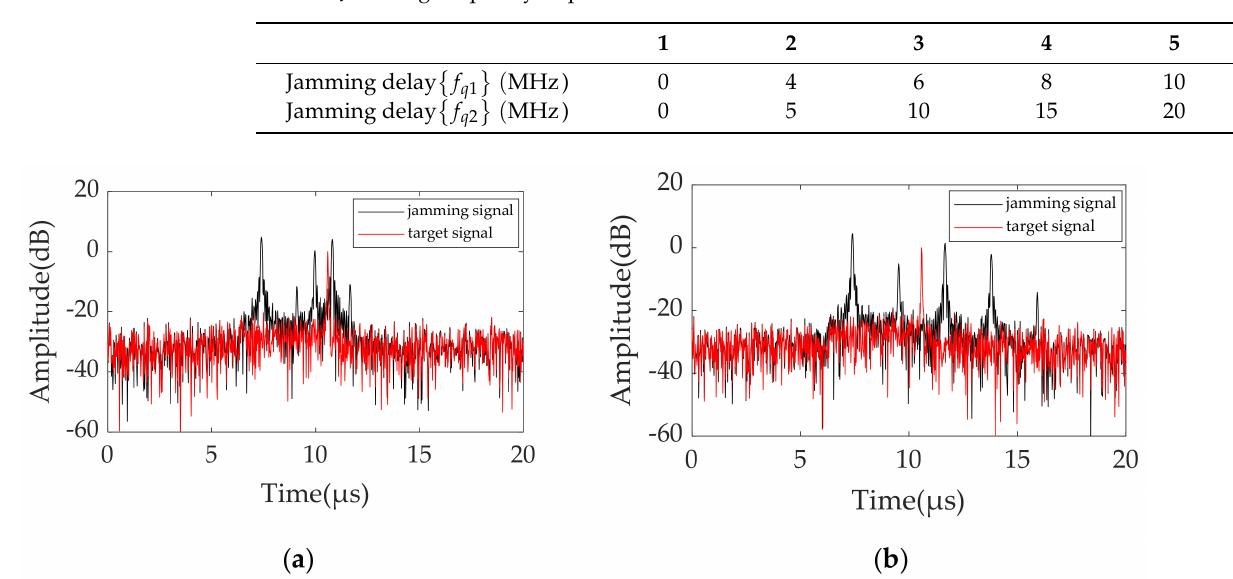
Figure 7. Comparison of imaging results with different jamming frequency sequences. ( a ) Jamming frequency sequences